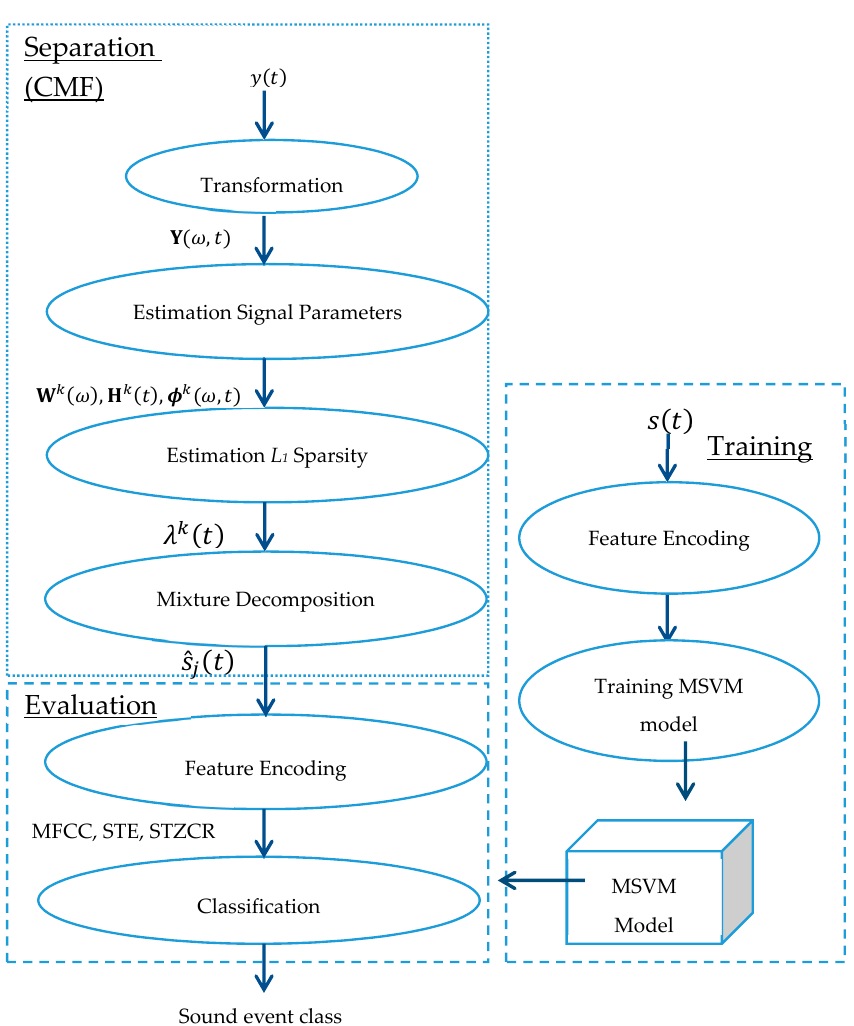
Figure 1. Signal flow of the proposed method.